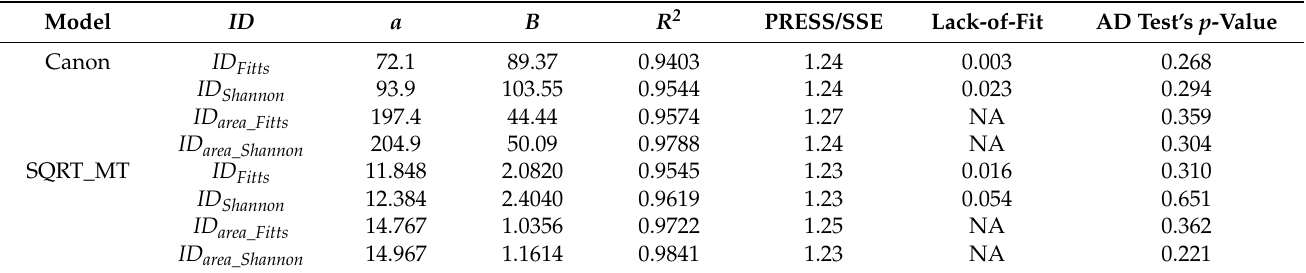
Table 12. Regression analysis for the amplitude of 512 pixels. ID area_Shannon had the best R-square and PRESS in both the Canon and SQRT_MT models.